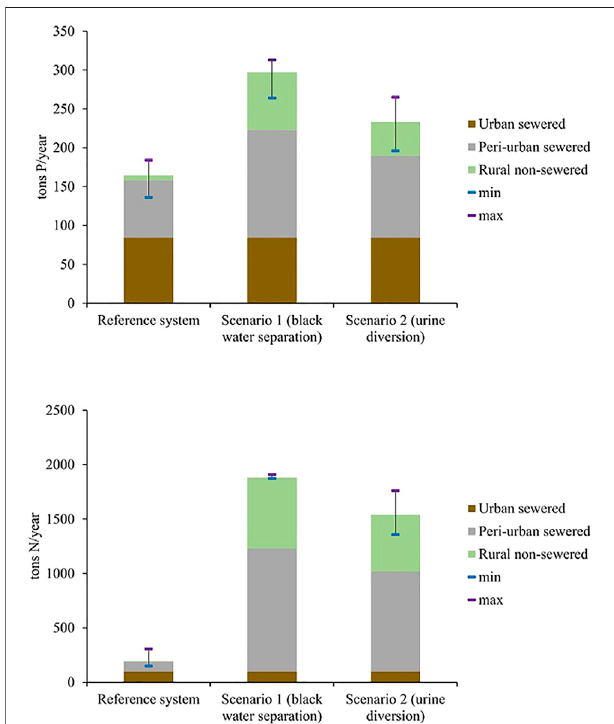
FIGURE 2 | Recovery potential of phosphorus (A) and nitrogen (B) (P/N tonnes/year) including the three studied regions in northern Finland and